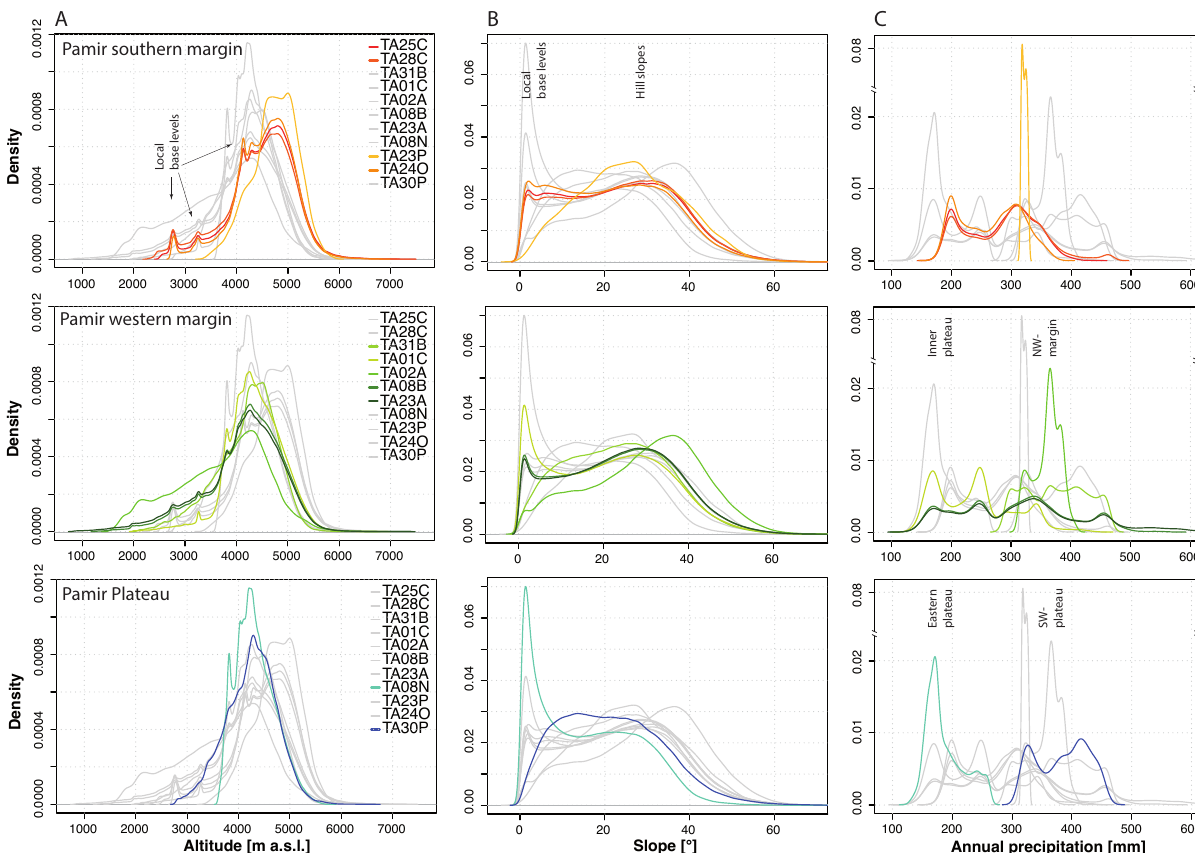
Figure 2. Frequency distributions of altitude (a) , slope (b) and precipitation (c) for individual sample basins, grouped due to their location at the southern or western margin of the Pamir or at the Pamir Plateau. Relative frequencies of altitude and slope were calculated from an ASTER GDEM of 30m resolution and precipitation from the TRMM product 3B42 V7 (Huffman et al., 1997, 2007) (names of basins are the same as the sample names in Fig. 1 and Table